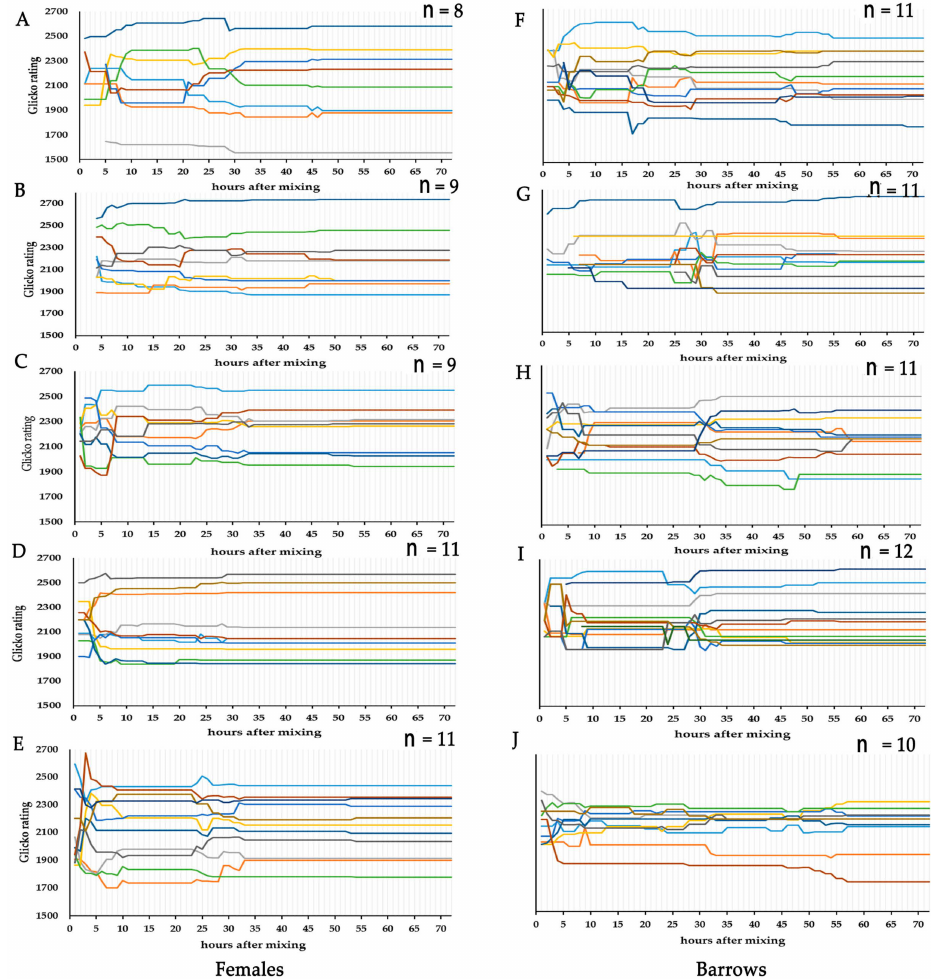
Figure 5. Temporal dynamics of individual Glicko ratings by pen. The change in individual Glicko ratings during 72 h post mixing for all pens ( A – J ). Each line represents the ratings of one individual with di ff erent colors representing individual IDs in each pen. Ratings were recalculated for individuals according to their agonistic interactions and were plotted on the y-axis against hours after mixing on the x-axis. Vertical dashed lines represent the end of each hour of